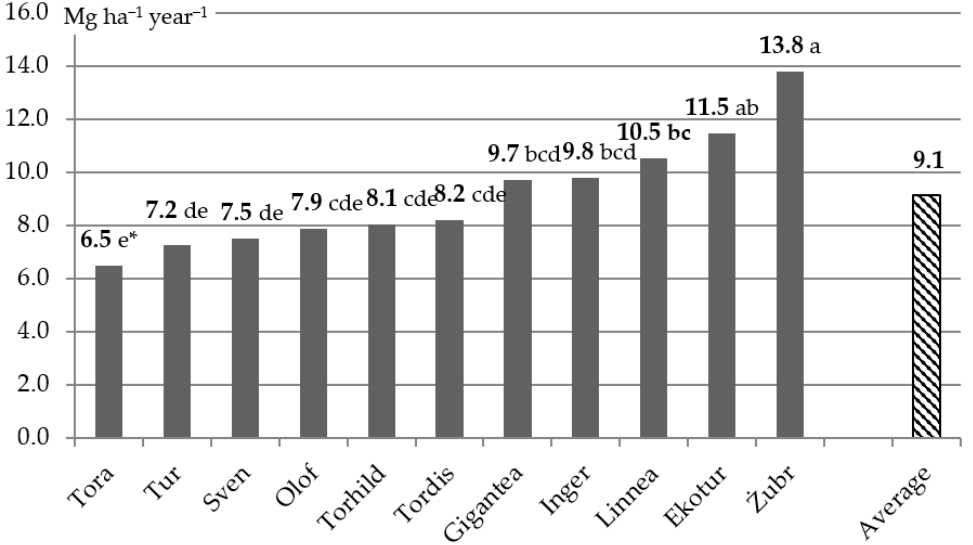
Figure 1. Dry matter yield (Mg ha − 1 · year − 1 ) of tested willow varieties. * Explanations: data marked with the same letters do not differ significantly at α = 0.05.